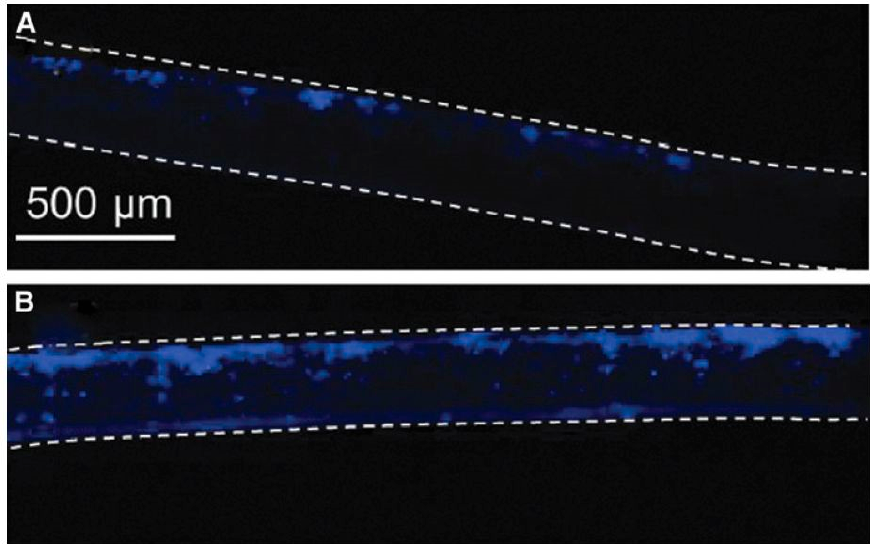
Figure 16. Cross-sectional images of ( A ) untreated and ( B ) Ar plasma-modified scaffolds sustained after in vitro study with BAECs in the serum medium for five days. Top and bottom scaffold surfaces are marked by dashed lines—reproduced with permission from [248]. Copyright Liebert, 2013.